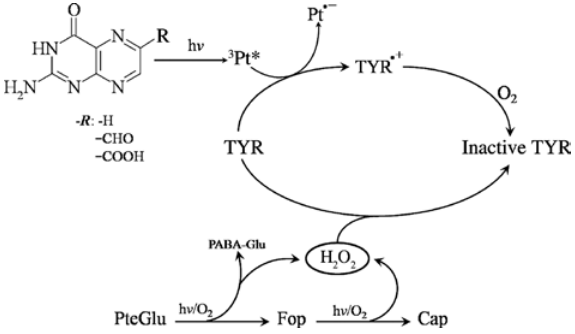
Scheme 5: Reaction pathways proposed for the inactivation of Tyrosinase (TYR) photosensitized by different pterin